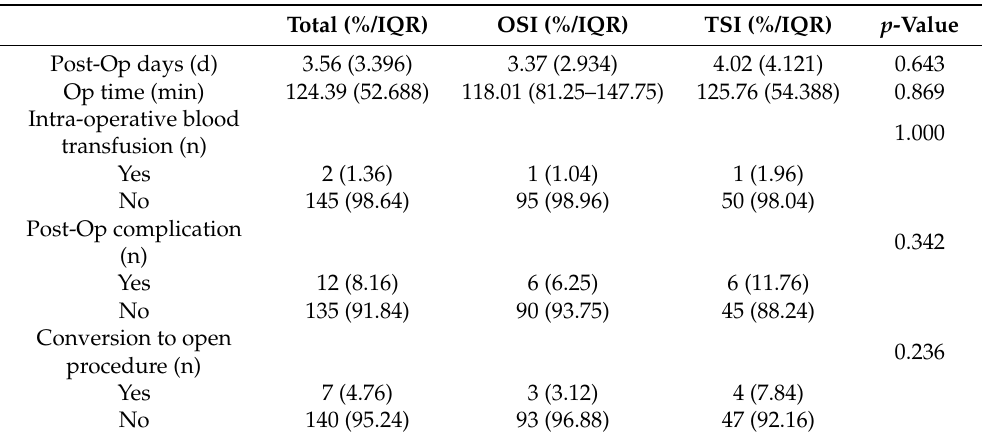
Table 3. Operative outcome analysis between one-stage intervention (OSI) group and two-stage intervention (TSI)